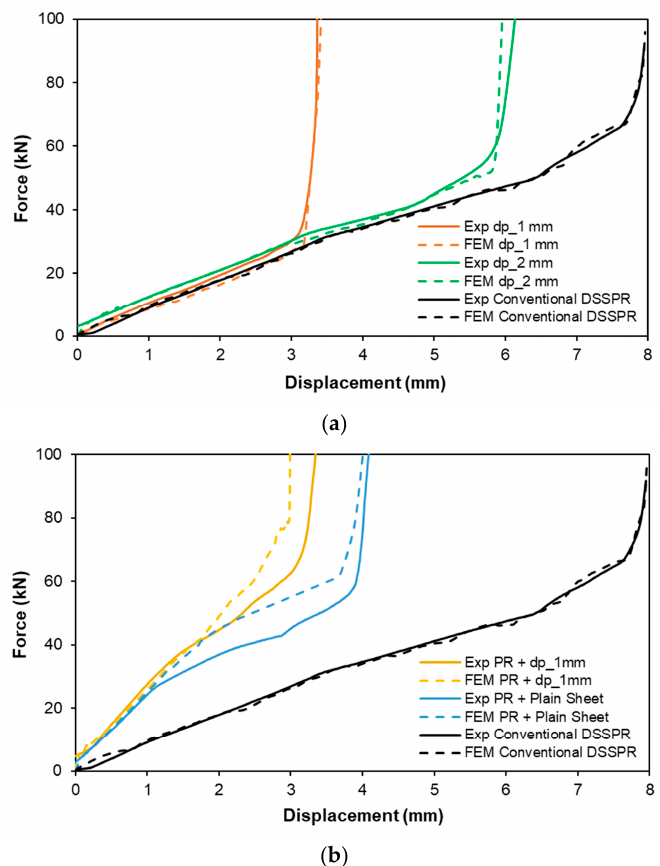
Figure 9. Force-displacement evolutions of the different cases obtained by means of numerical and experimental testing for ( a ) sheets with a flat-bottom hole in each sheet and ( b ) with an initial pre-riveting operation. The results from conventional DSSPR are included for reference.